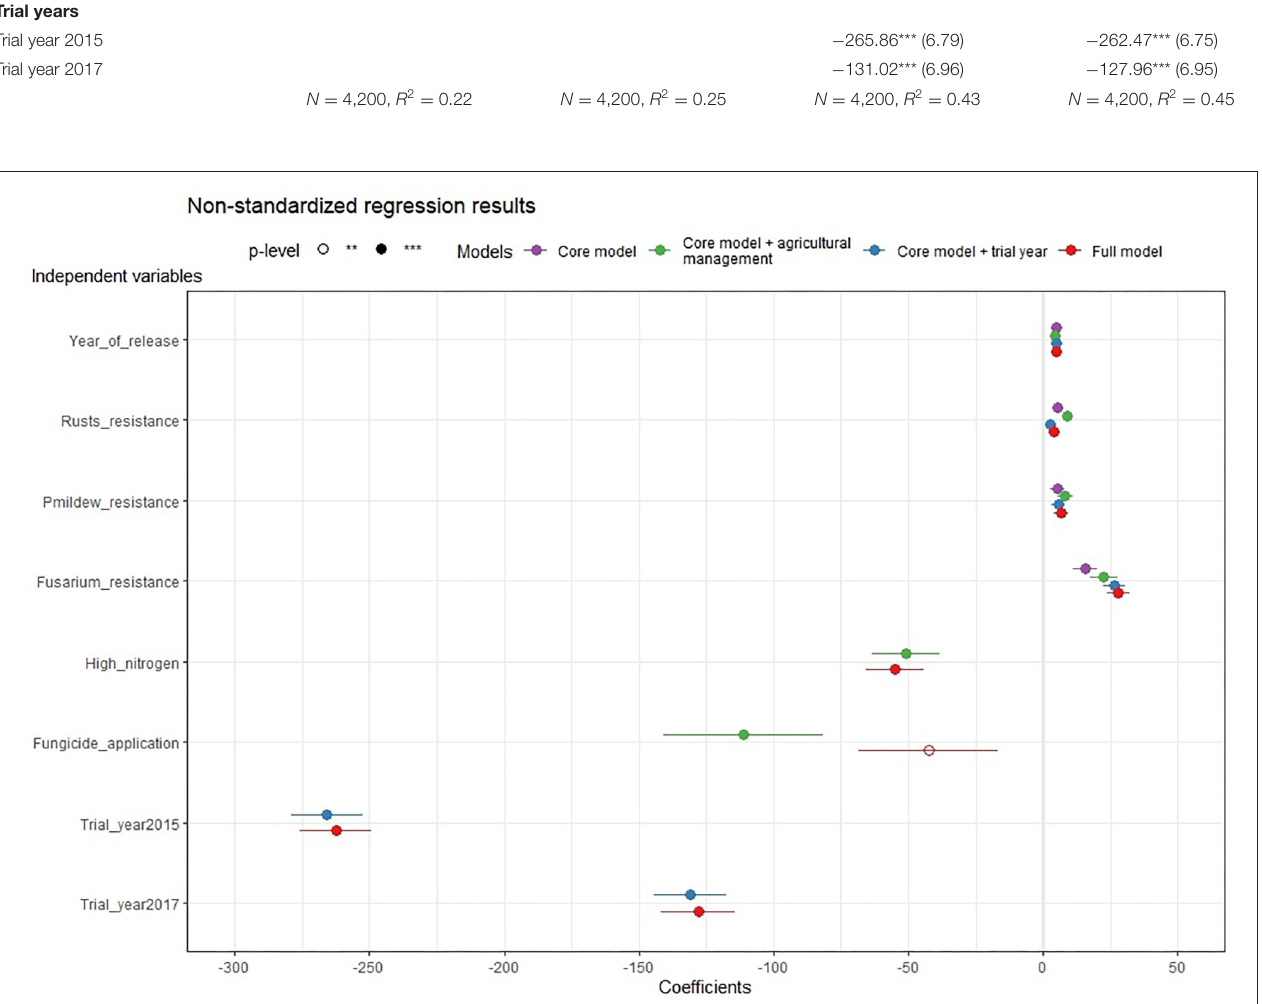
FIGURE 1 | Forest plot of the non-standardized regression results for all regression models. The dependent variable of all models is the Gross margin. Different models are identified by different colors. The plot shows the magnitude (indicated by the circle position) and uncertainty (tails around the circles show the 0.95 confidence interval) of variable coefficients. A filled circle indicates statistical significance at the level p < 0.001 and a not filled circle at the level p < 0.01. When a circle is positioned to the right of the vertical zero lines, it means that the variable increases the gross margin of the dependent variable. For every additional unit of a variable (e.g., one additional percentage point of healthy leaf area), the gross margin increases the coefficient of the variable. And when a point is located to the left of the zero lines, the variable is estimated to have a negative influence on the dependent variable so that it decreases the gross margin.